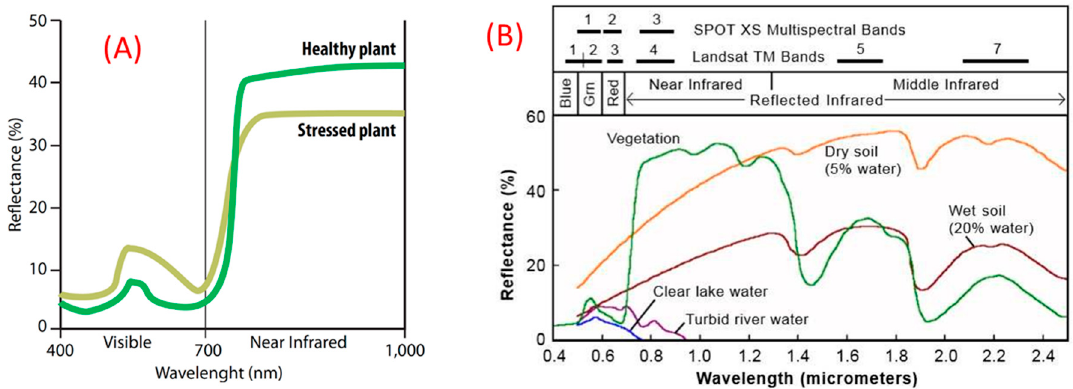
Figure 2. Typical reflectance spectrum of ( A ) a healthy and a stressed plant (taken from Govaerts and Verhulst [143]) and ( B ) soil, water, and vegetation (taken from Mondal [82]). Table 2. Some recently used vegetation indices for remote sensing applications in precision agriculture *.